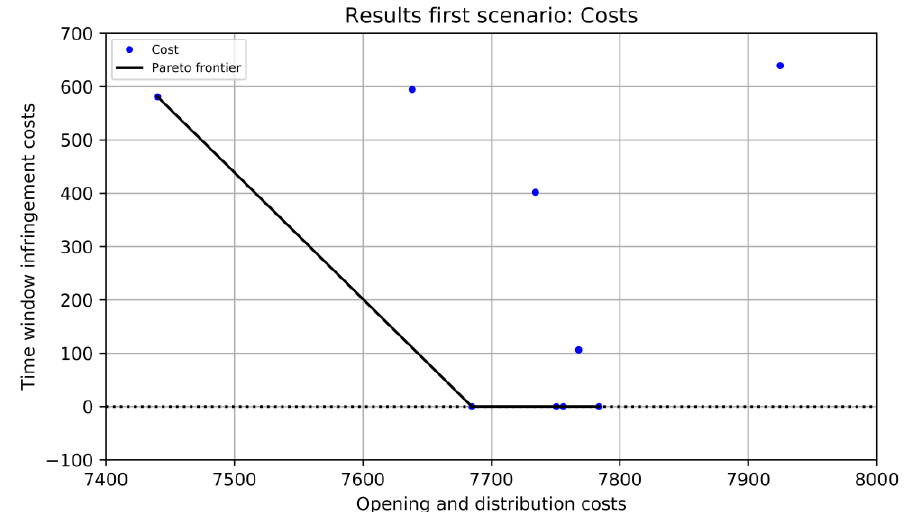
Figure 5. Pareto frontier for the first scenario.